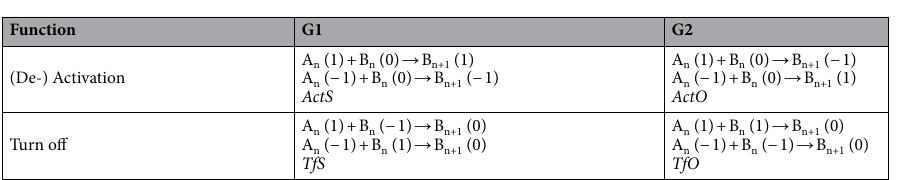
Table 2. Proposed functional classification of the rules. The significant rules show a specific nested structure and possible functional role as defined by the four relations: (de-)activation, turn off, same state and opposite state. The two-by-two combination of these features (see the text) point to a functional process described by an appropriate interaction matrix.